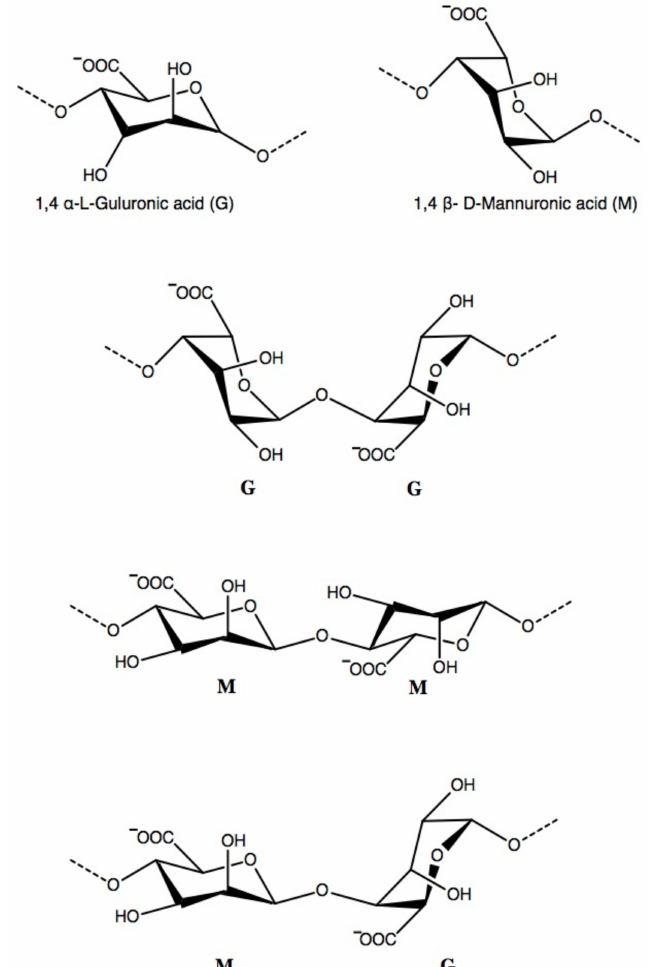
Figure 2. The chemical structure of 1,4 α - L -guluronic acid and β - D -mannuronic acid in